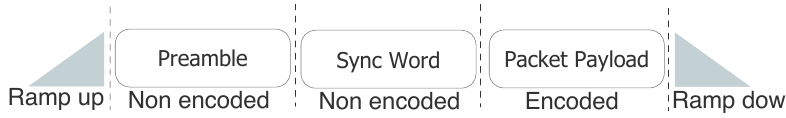
Figure 10. DASH7 message frame